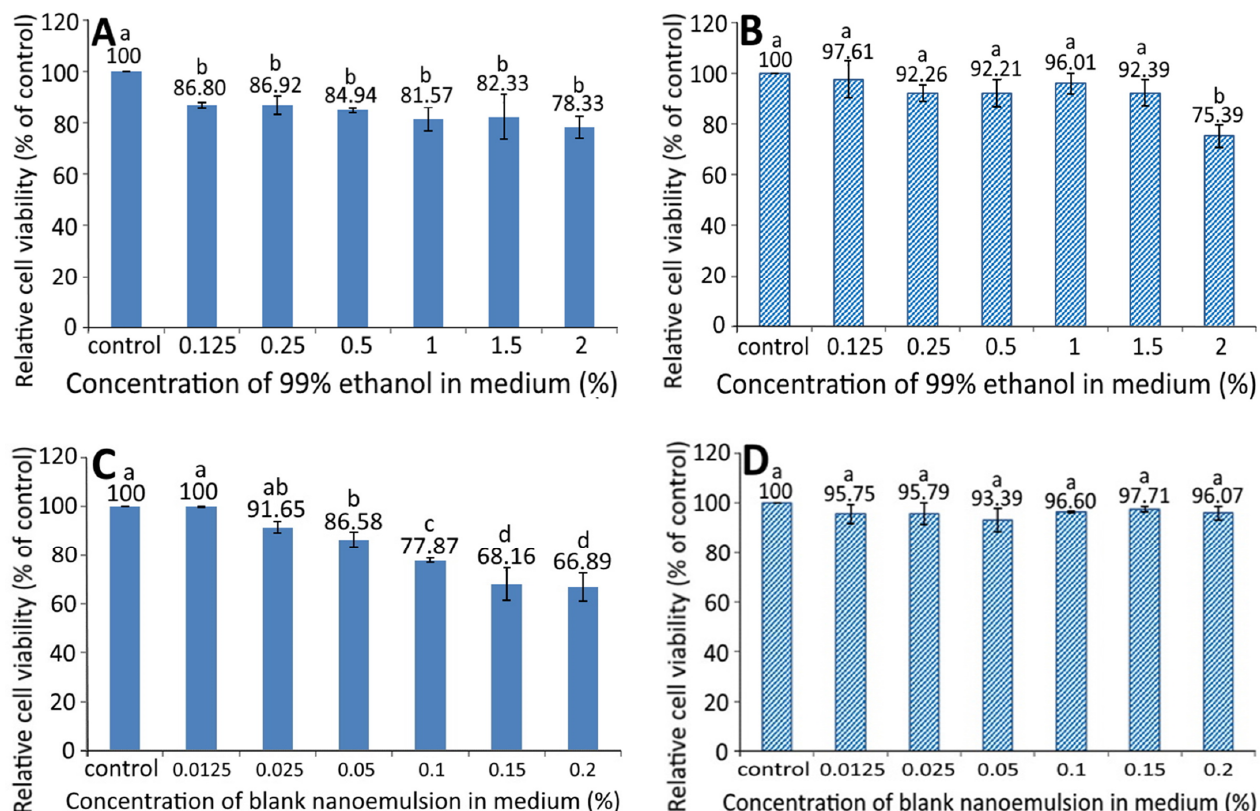
Figure 3. Effect of different concentrations of 99% ethanol and blank nanoemulsion (without resveratrol) on the growth of pancreatic normal cells MS1 ( A , C ) and pancreatic cancer cells BxPC-3 ( B , D ) after 48 h incubation as measured by MTT assay. Control represents that cells were incubated in RPMI medium only. Data are shown as mean ± standard deviation ( n = 3) and data with different small letters (a–d) are significantly different at p < 0.05.